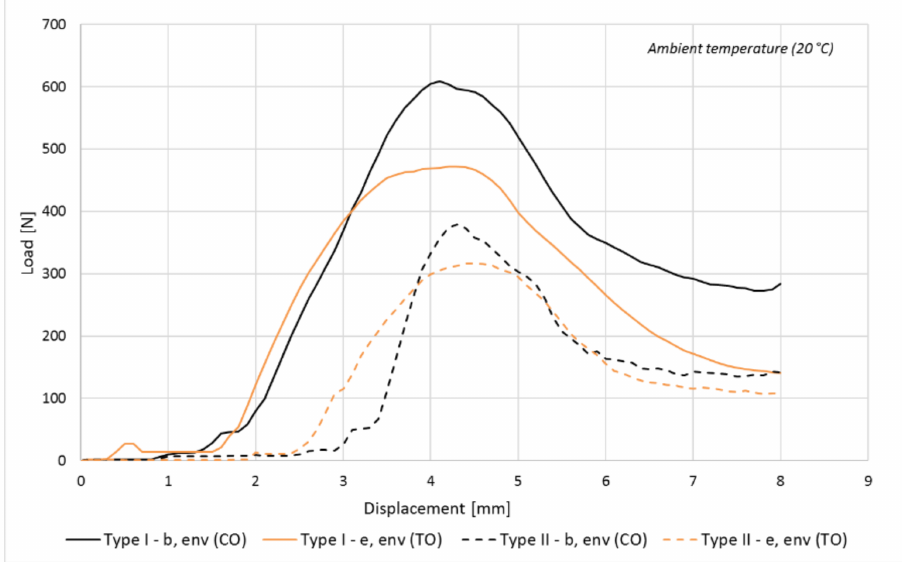
Figure 22. Type I seals vs. Type II seals closing force for conical shape vs. toroidal shape